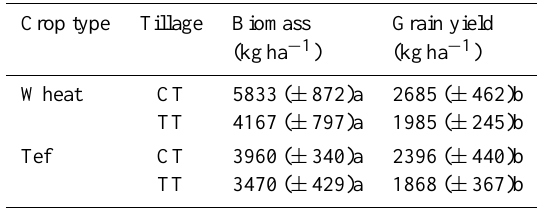
Table 3. Biomass and grain yield of wheat and tef from conserva- tion and traditional tillage at Enerata,